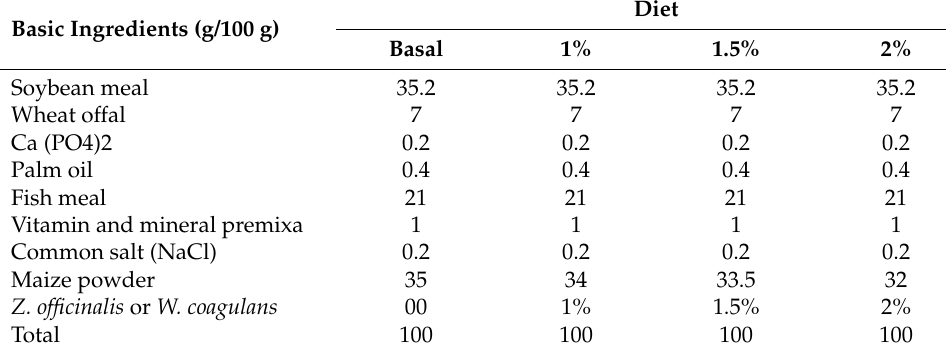
Table 2. Fortification of the